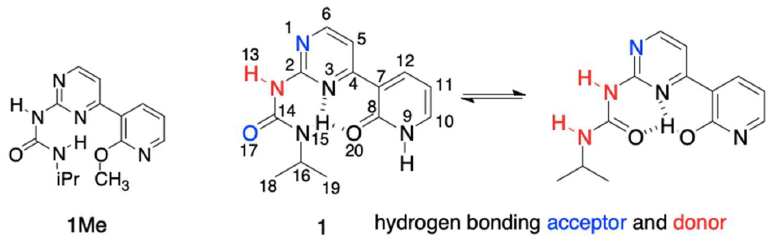
Figure 1. The structures of 1 and 1Me and their atomic numbering.